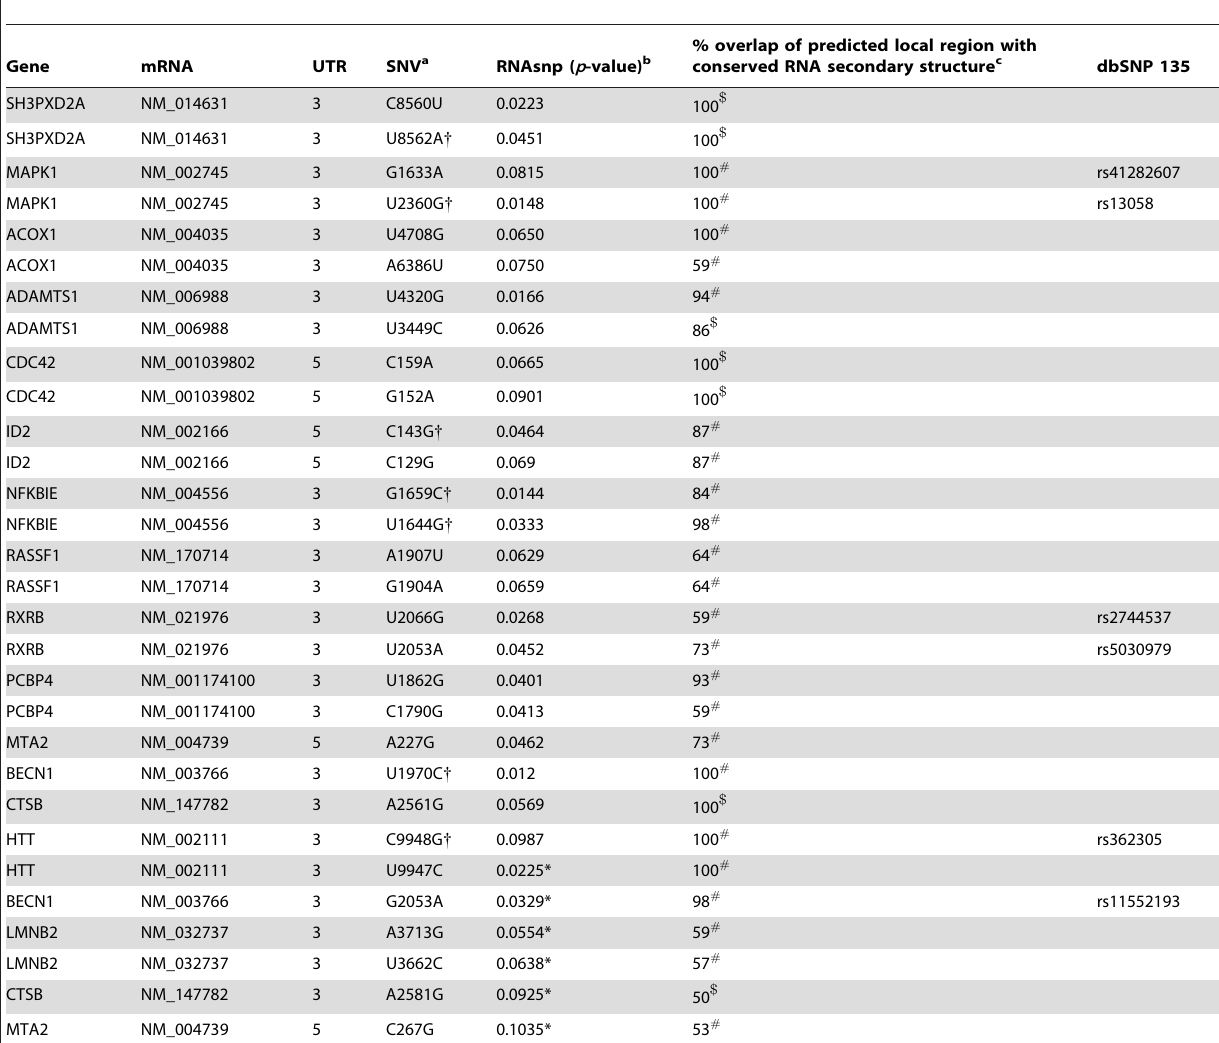
Table 2. List of genes which have more than one disruptive SNV (combined high-confidence and medium-confidence candidates) in the